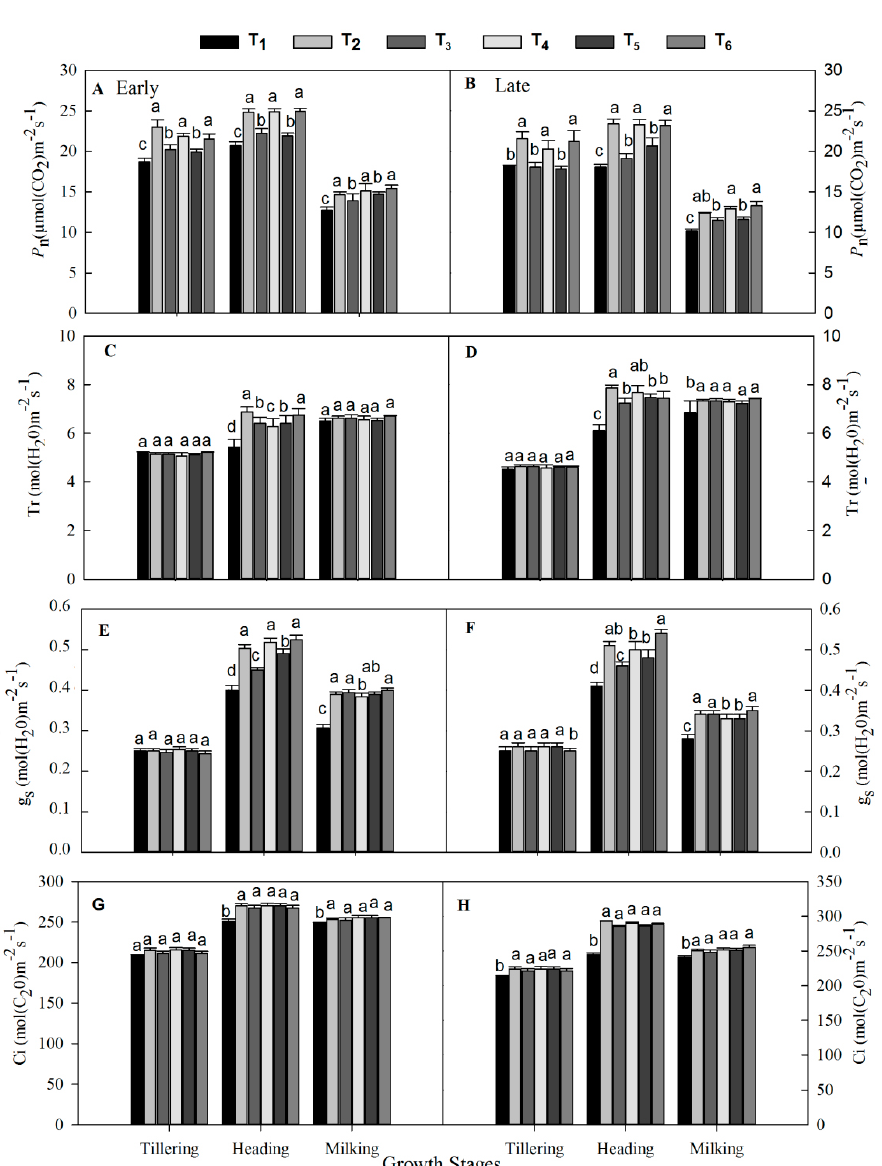
Figure 1. Net photosynthesis rates during season early ( A ) and late ( B ), transpiration rate at early ( C ) and late ( D ) seasons, stomatal conductance at early ( E ) and late ( F ) seasons, and intercellular CO 2 concentration at early ( G ) and late ( H ) seasons of rice at the tillering, heading, and milking stages under organic manure and inorganic fertilizer application. Vertical bars represent the standard error of mean. Di ff erent litters above the column indicate statistical significance at the p < 0.05.